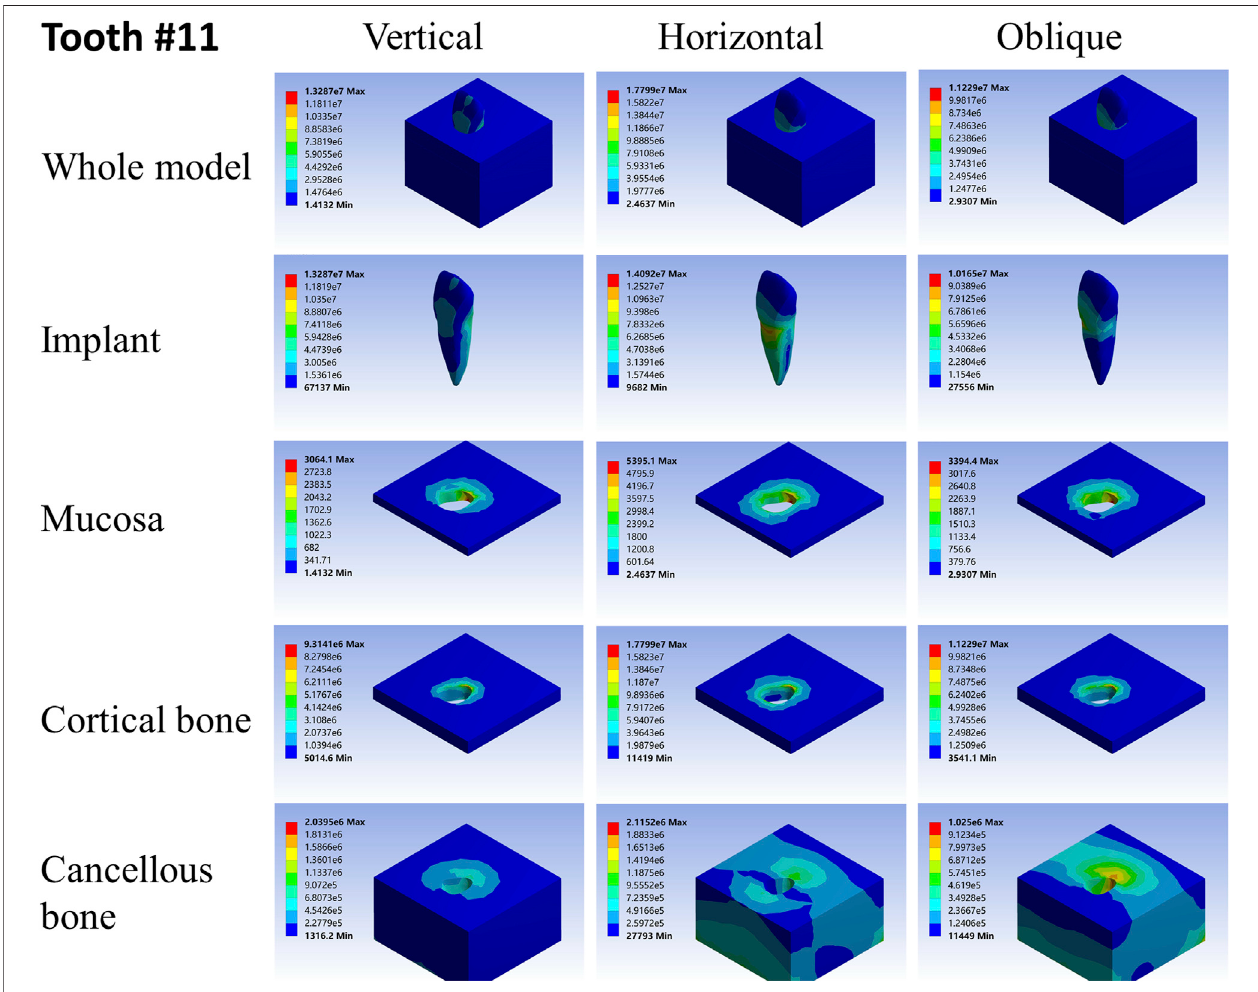
FIGURE 7 | Stress distribution of 11 under 100-N